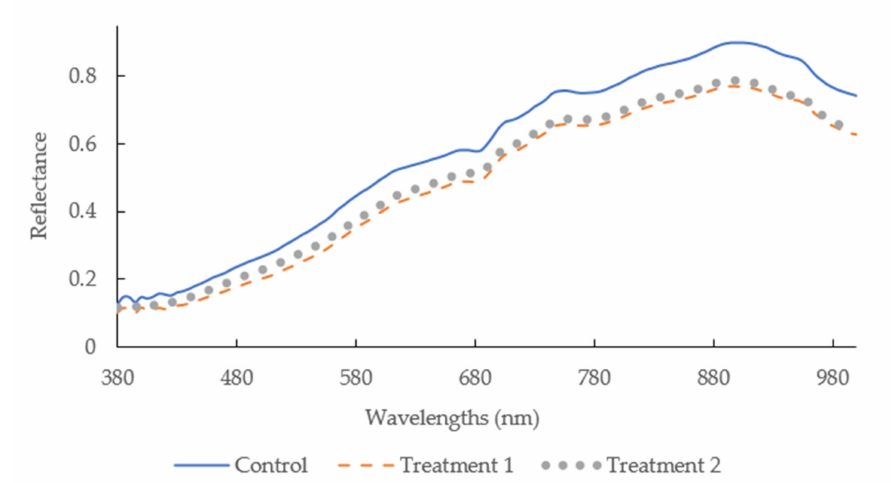
Figure 1. Mean spectra of the sausages with di ff erent casings in the spectral range of 380–1000